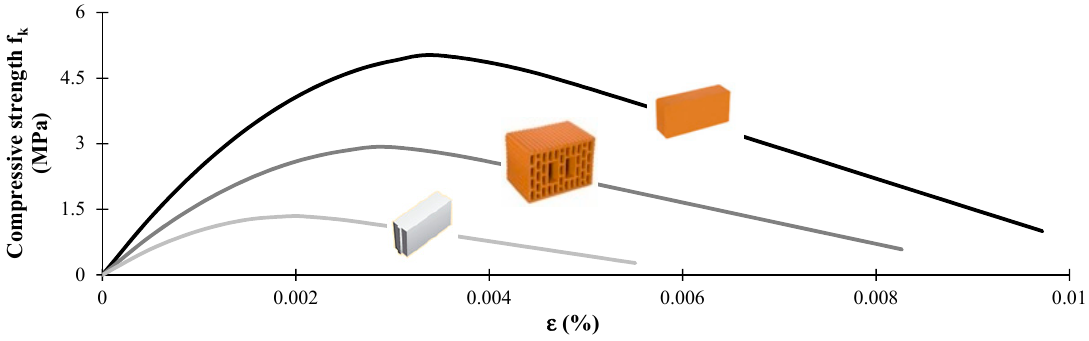
Figure 4. Stress-strain relation for three masonry infill types according to Kaushik [36].